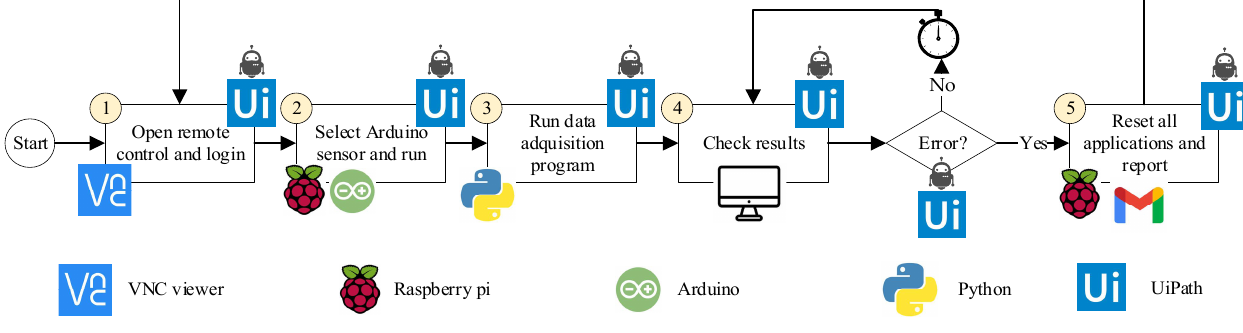
Figure 9. Process redesign with RPA (To − Be).